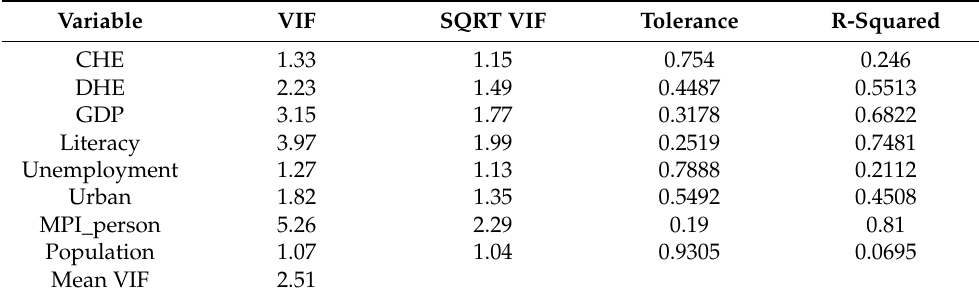
Table A1. Multicollinearity Diagnostics